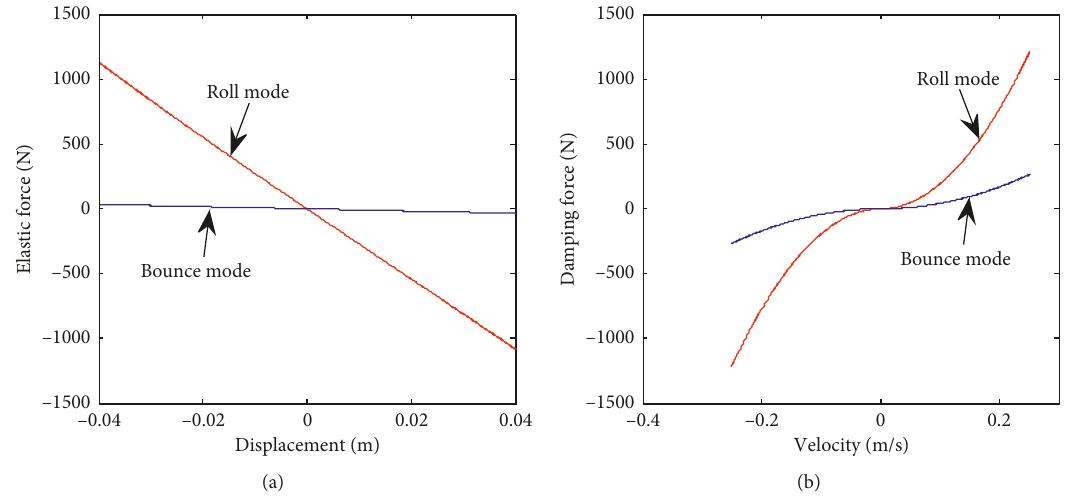
Figure 8: Elastic force and damping force in the two modes.